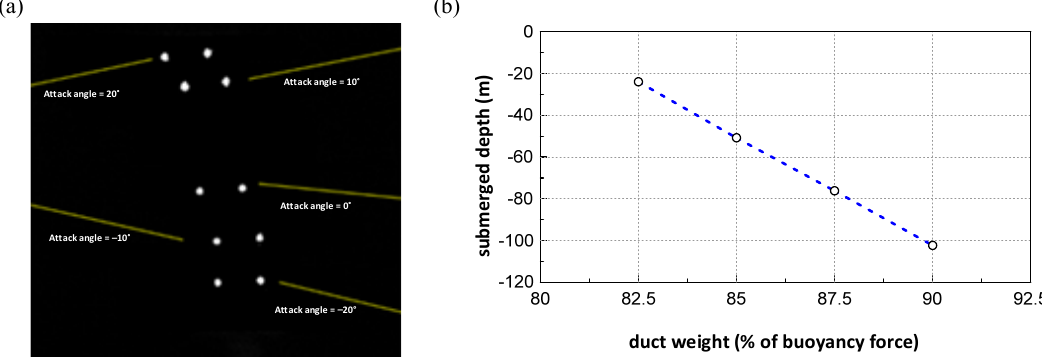
Figure 15. ( a ) Experimental result for the neutral position of the duct by different attack angle of the wings [16]; ( b ) sub- merged depth with different design weight of the duct.